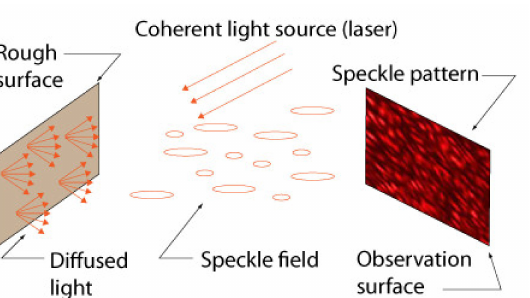
Figure 11. Observation of the objective phenomenon. A coherent light source (laser) illuminates a rough surface that diffuses light in open space leading to the construction of a speckle field. The speckle field can be observed by placing an observation plate in front of the illuminated surface.